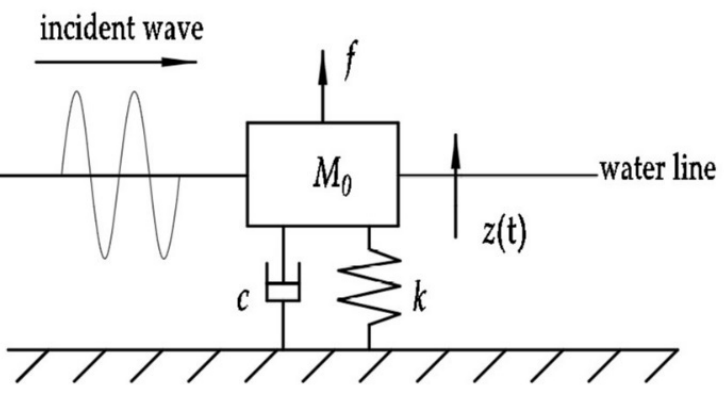
Figure 1. Mechanical model.